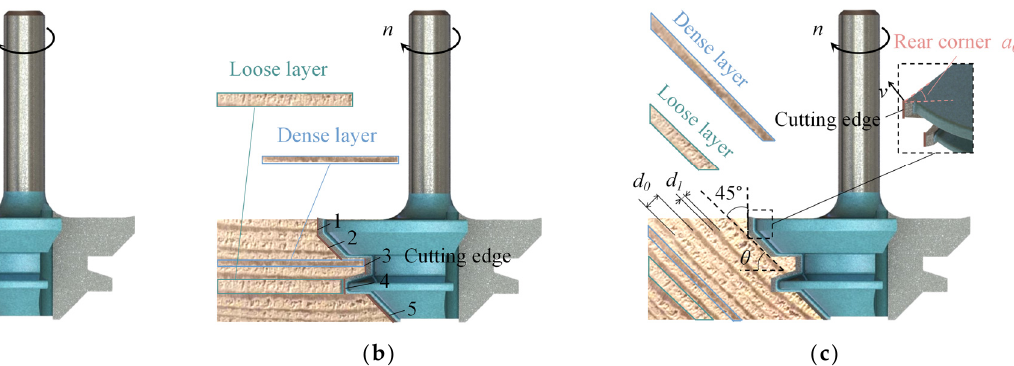
Figure 2. Analysis of the forces during circumferential milling of wood. ( a ) The state when the cutting edge is parallel to the annual wheel of the wood. ( b ) The state when the cutting edge is perpendicular to the annual wheel of the wood. Numbers 1 to 5 refer to the serial numbers of the five cutting edges of the circumferential milling tool. ( c ) The state of cutting edge No. 1 when it is at an angle of 45° to the annual wheel of the wood and the parameters utilized for the calculation of the tool and the layer of the annual wheel of the wood are shown.